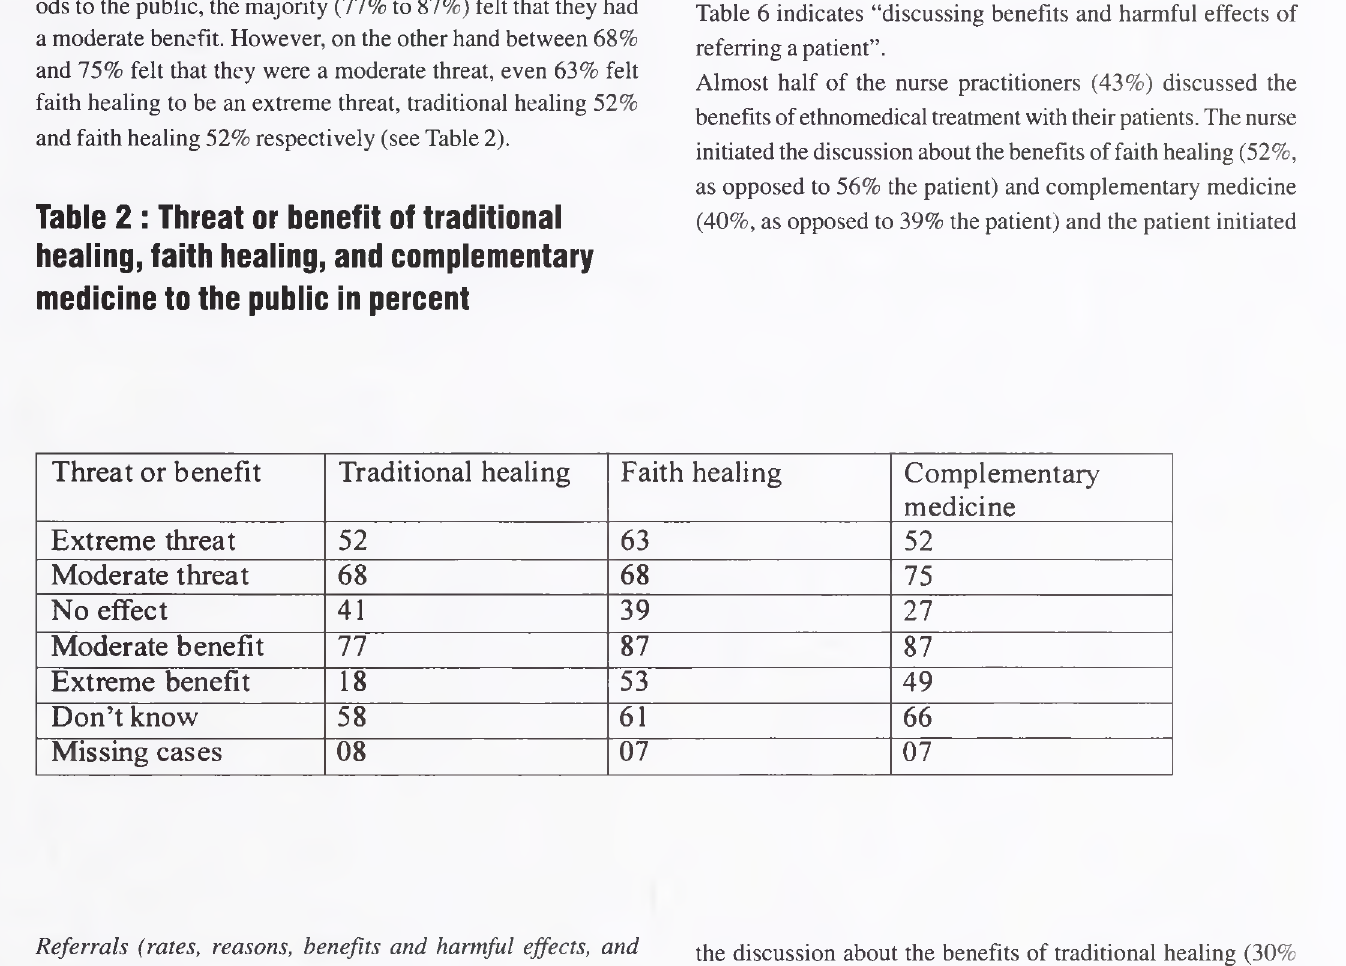
Table 6 indicates “discussing benefits and harmful effects of referring a patient”.